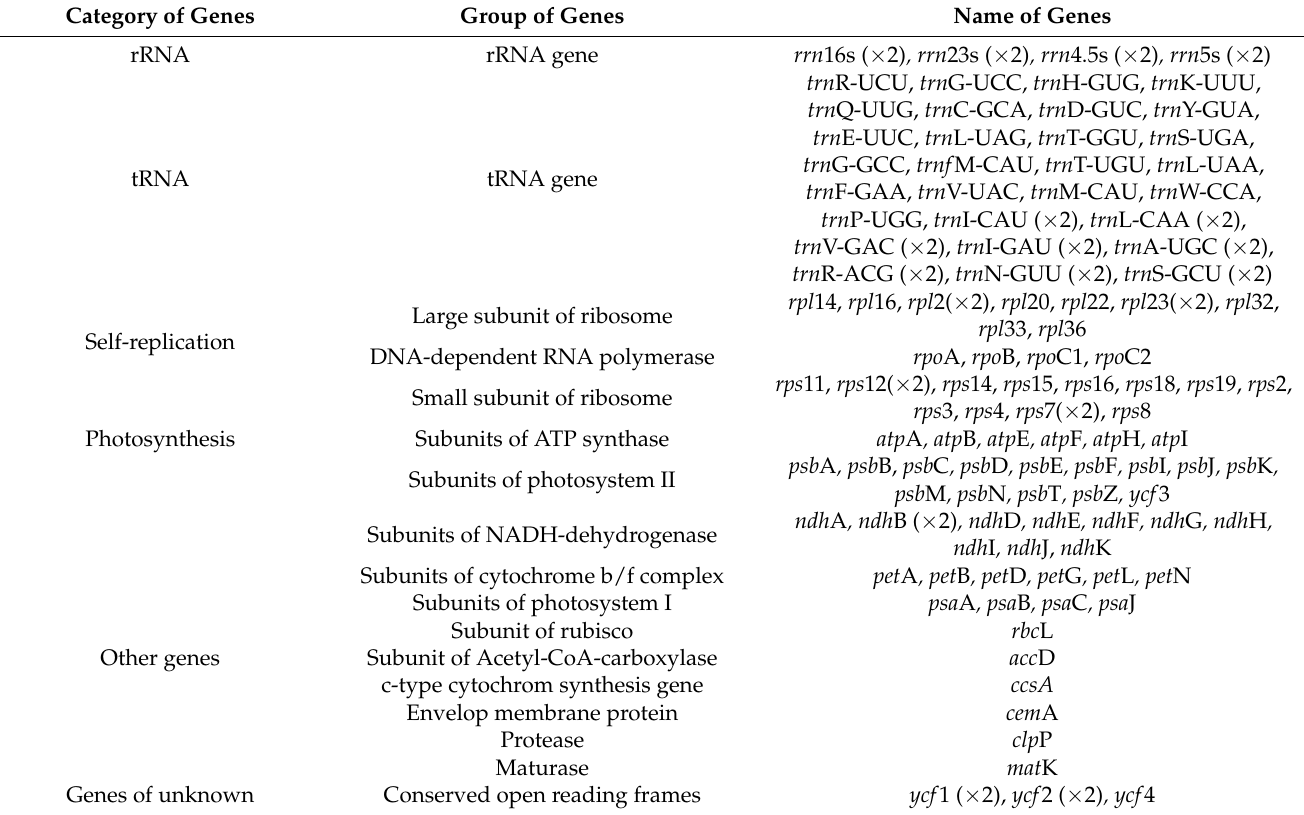
Table 2. Genes identified in the plastome genome of L. bubifera